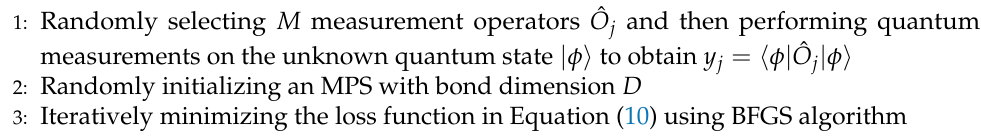
Algorithm 1 QST from sparse